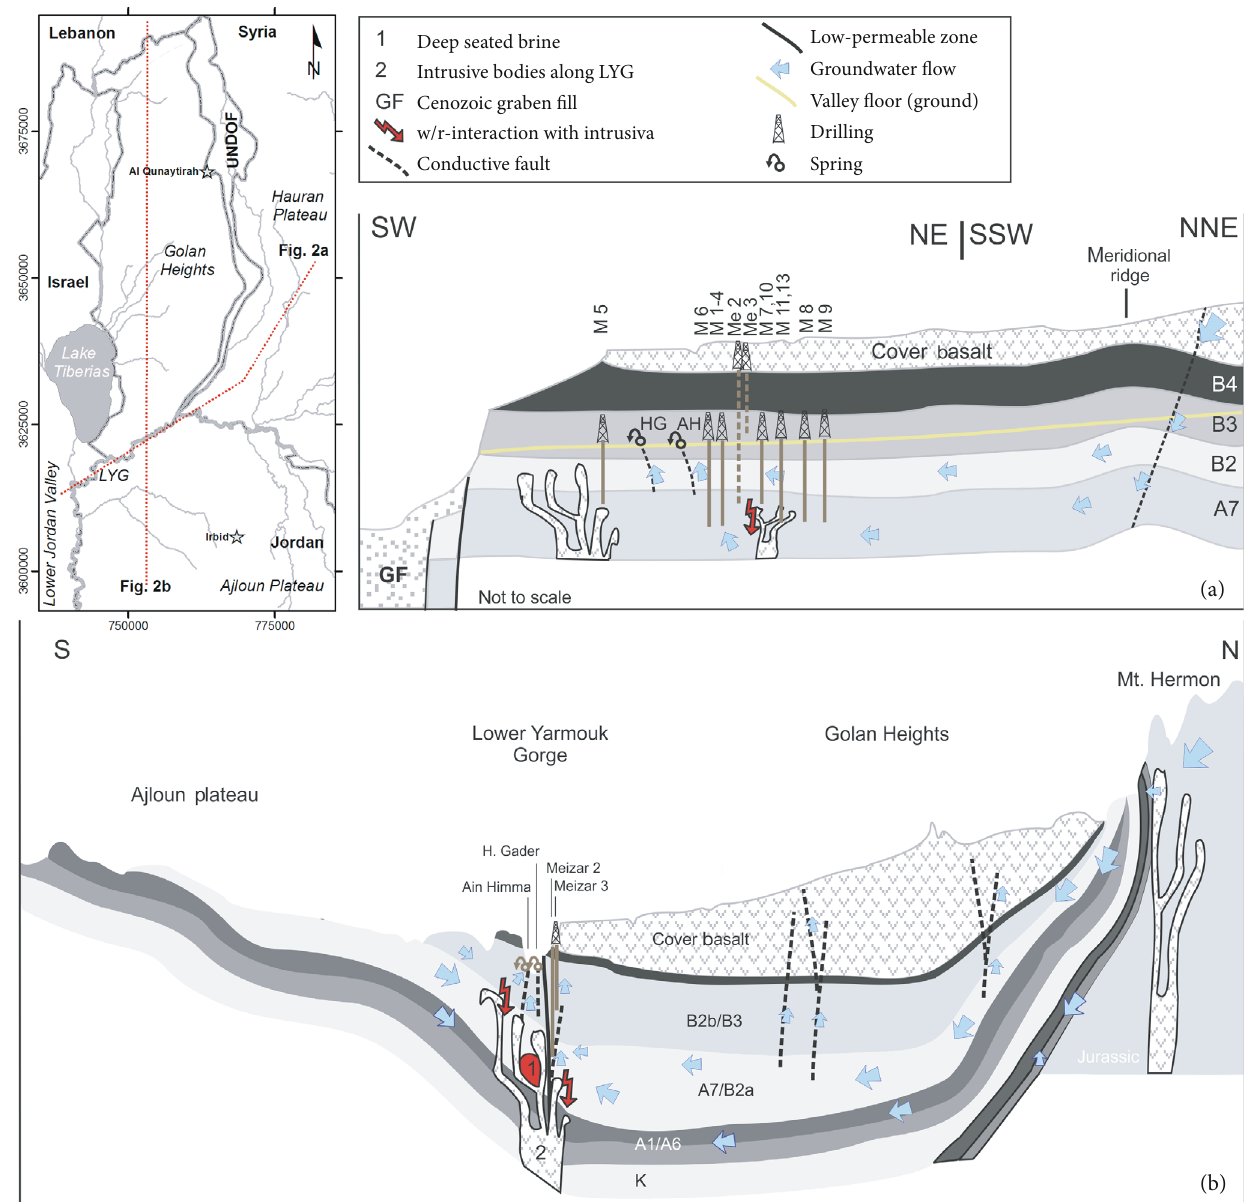
Figure 2: Schematic geological cross sections (not to scale). Section (a) starts in the Lower Jordan Valley, continues through the LYG, and branches into the Hauran NE-ward, while section (b) cuts from the Ajloun northward across the LYG and the Golan Heights into Mt. Hermon. The map shows the location of cross sections in